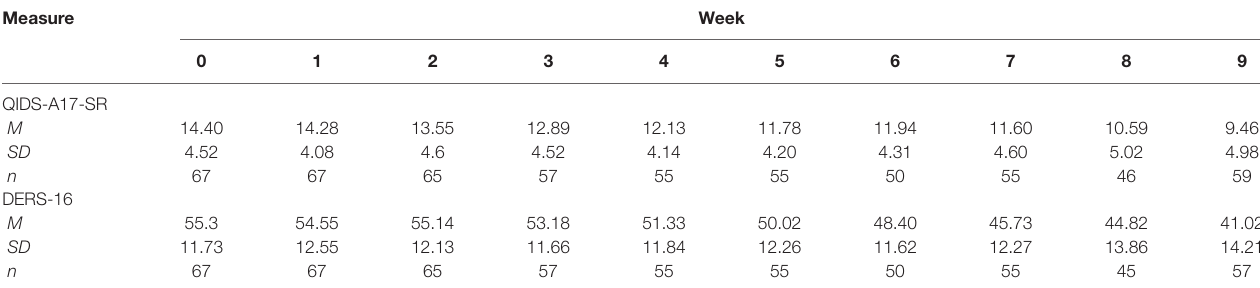
TABLE 2 | Observed means, standard deviations, and number of observations for outcome and processes over the treatment period. Measure